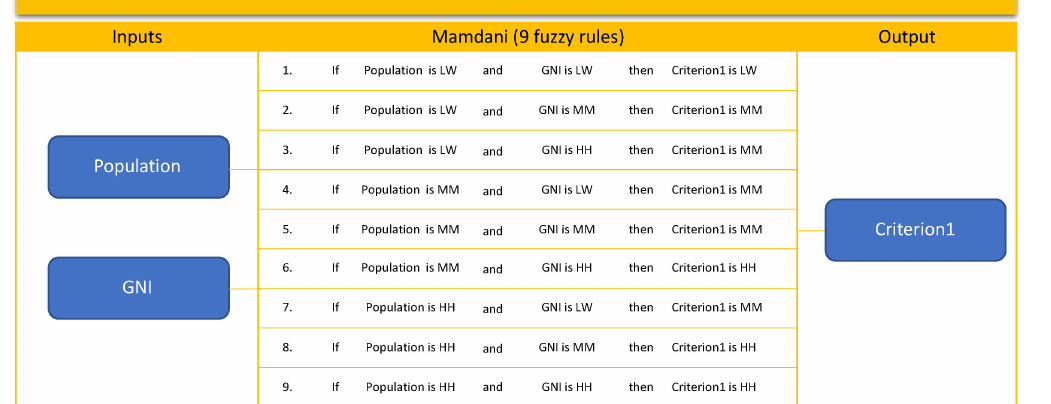
Figure 5. First Type-1 fuzzy system population and GNI variables.